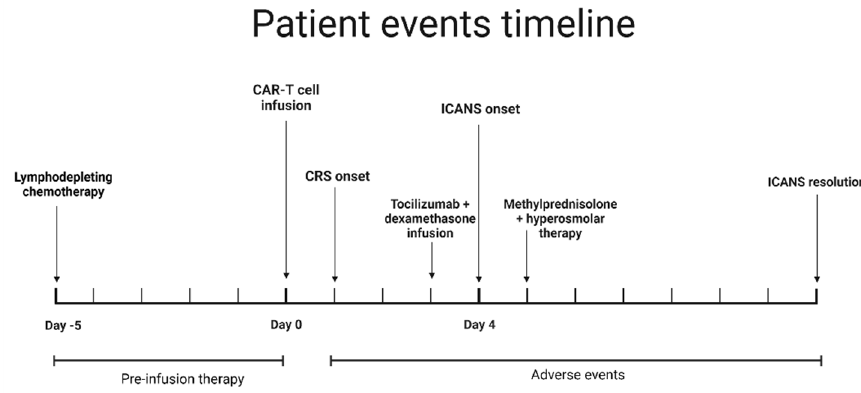
Figure 6. A timeline depicting the most important events in this patient’s